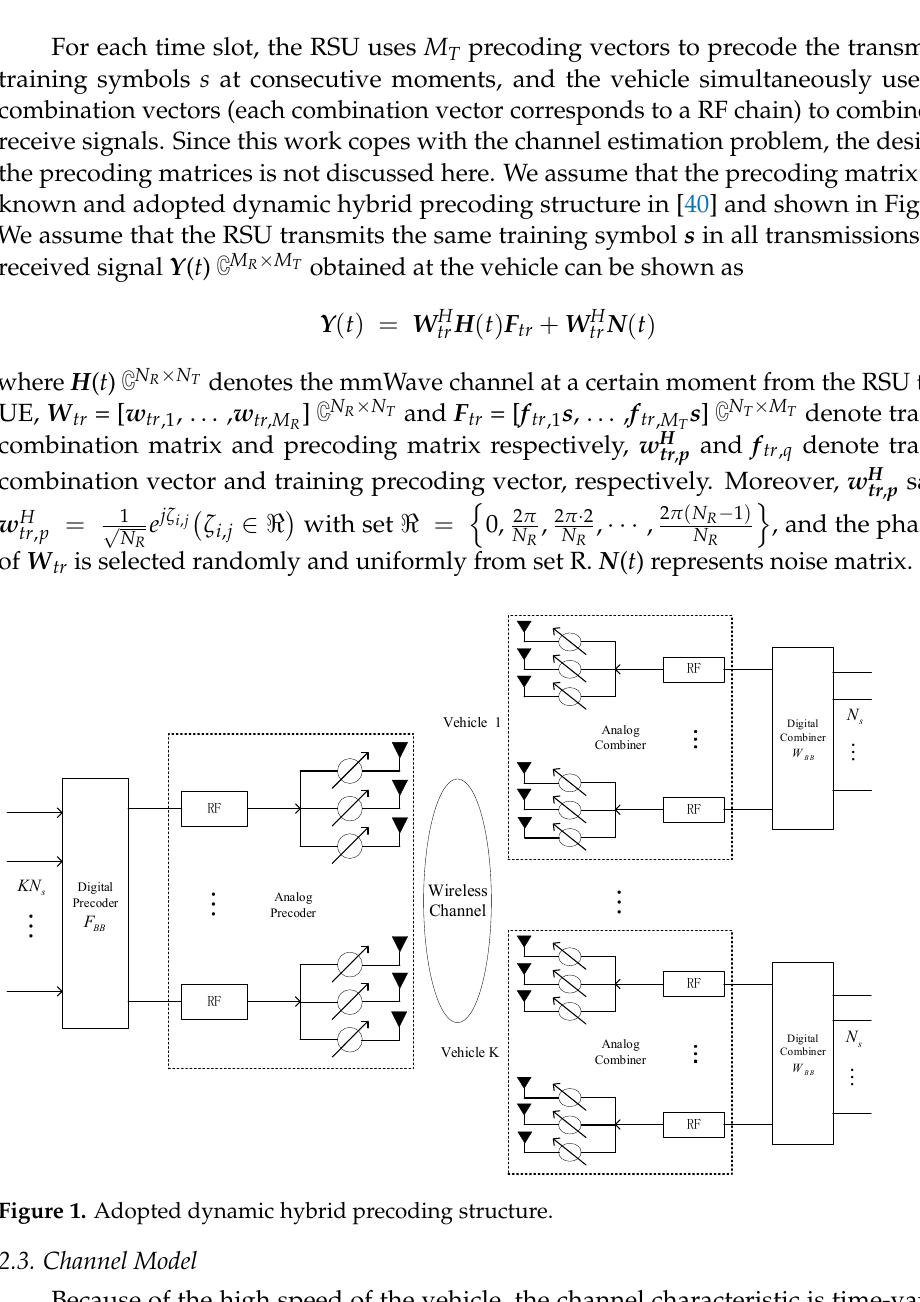
Figure 1. Adopted dynamic hybrid precoding structure.